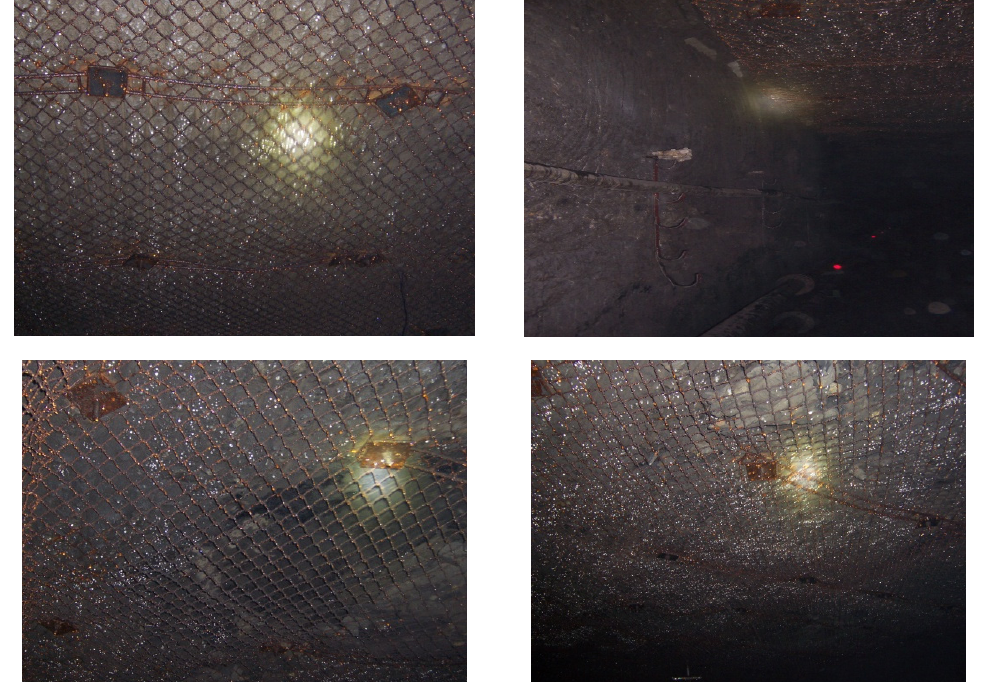
Figure 13. Field application of optimized support design.